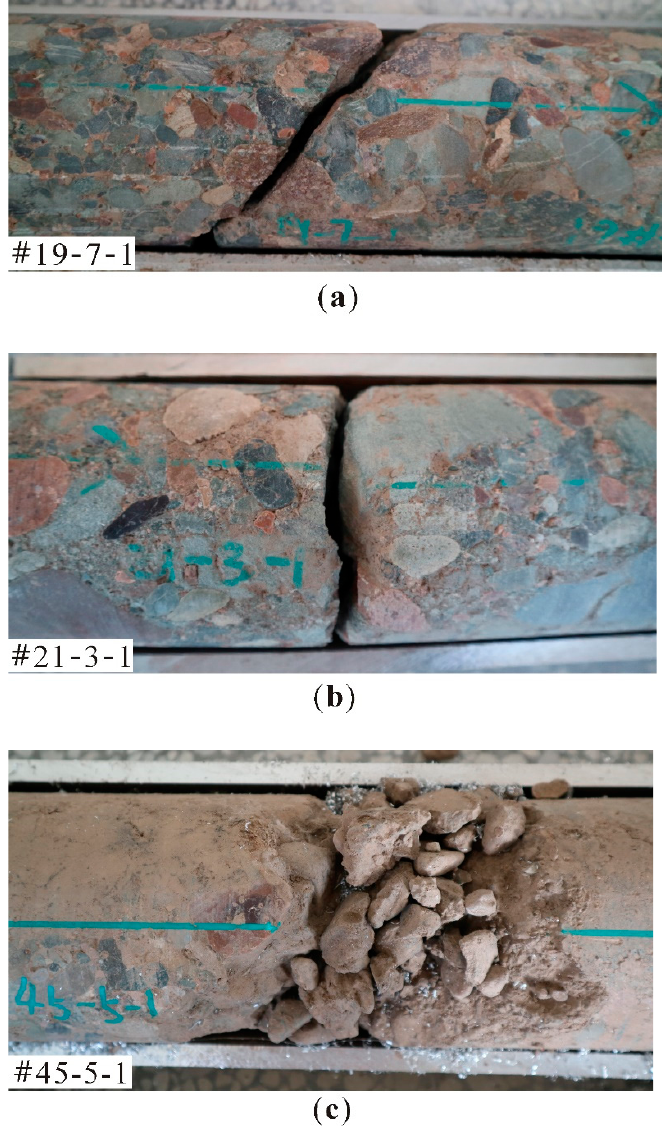
Figure 5. Morphology features of hydraulic fractures. ( a ) Straight hydraulic fracture, oriented 107°, deviates slightly from the east–west direction. ( b ) Microwave hydraulic fracture. The fracture edge is incomplete. ( c ) Crushed zone with scattered gravel.